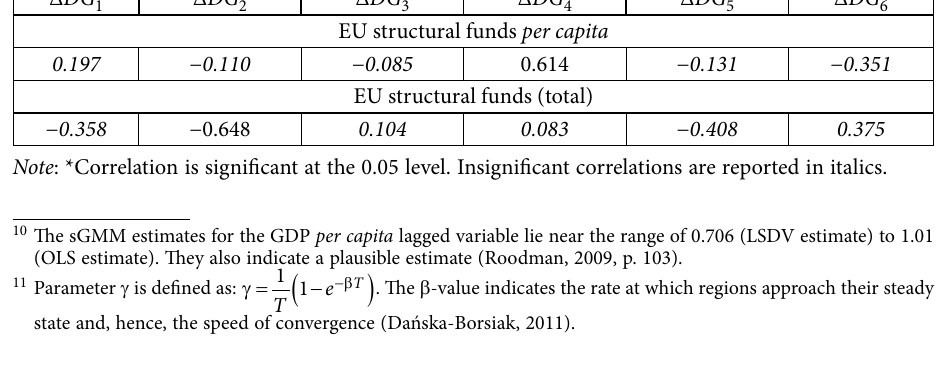
Table 6. Correlations between the volume of EU structural funds and progress in reducing the develop- ment gaps in Polish regions (2004–2015) (source: own calculations) ∆ DG 1 ∆ DG 2 ∆ DG 3 ∆ DG 4 ∆ DG 5 ∆ DG 6 0.197 − 0.110 − 0.085 − 0.358 −0.648